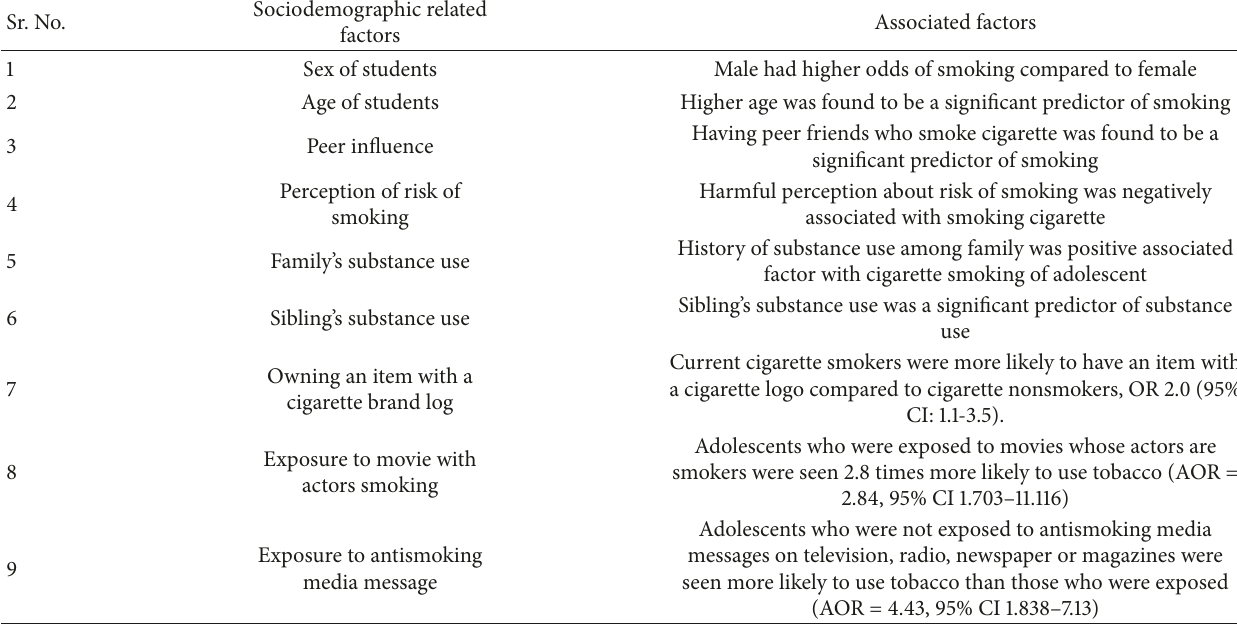
Table 3: Associated factors of current cigarette smoking among school adolescents in East Africa. Sr. No.